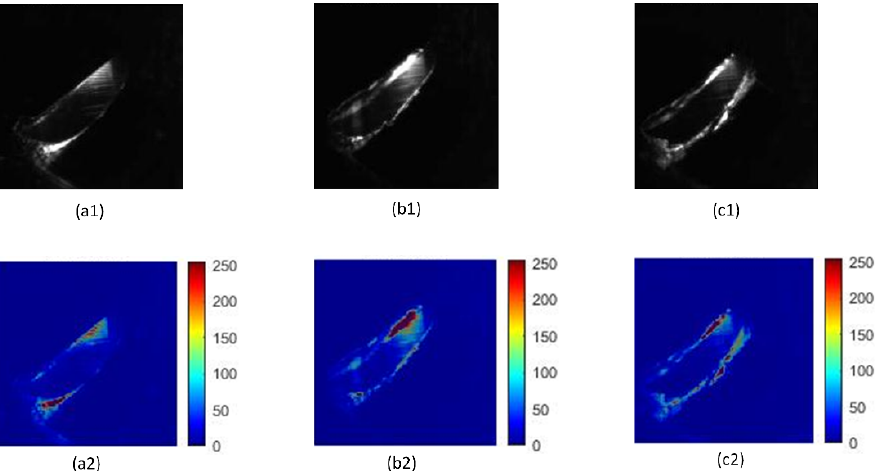
Figure 9. Grad–CAM-visualized results with NG images for ( a2 – c2 ), where the ( a1 – c1 ) are the orig- inally captured images. originally captured